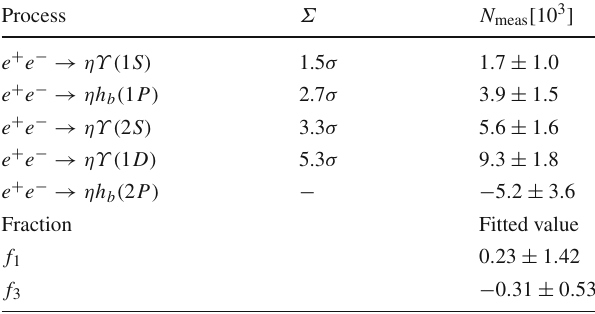
Fig. 4 M miss (η) distribution after the subtraction of the fitted back- ground component. The blue solid line shows the signal component of the global fitting function, while the red dashed line represents the Table 1 Results of the fit of M miss (η) . Significance ( Σ ), measured sig- nal yield ( N meas ), and Υ J ( 1 D ) triplet fractions are reported. The errors on N meas and f J are statistical only, while the fit-related systematic uncertainties are taken into account in the significance